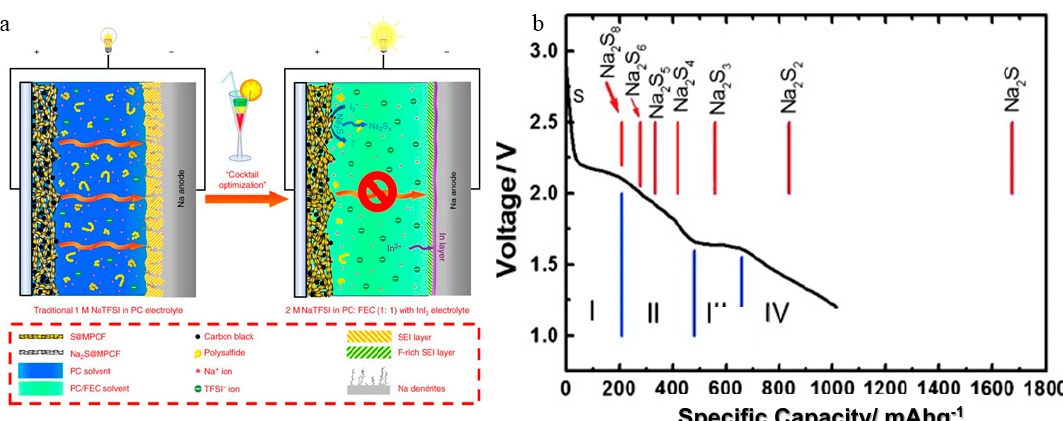
Figure 1. ( a ) Schematic illustration of RT -Na/S batteries [11] ( b ) Reaction stages during discharge for RT-Na/S batteries [8]. Reprinted with permission from Wiley, copyright 2019.